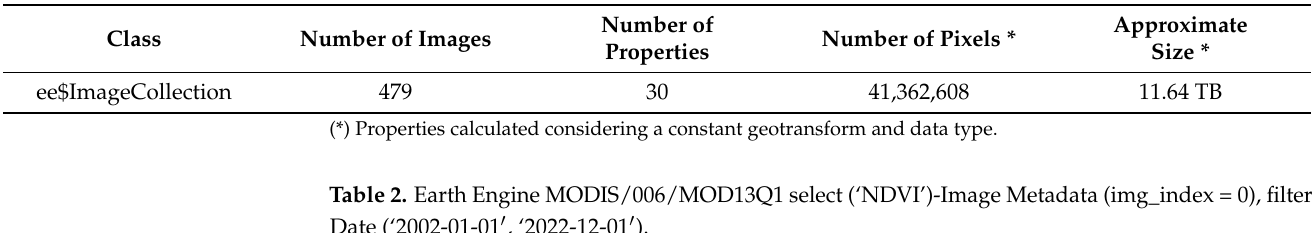
Table 2. Earth Engine MODIS/006/MOD13Q1 select (‘NDVI’)-Image Metadata (img_index = 0), filter